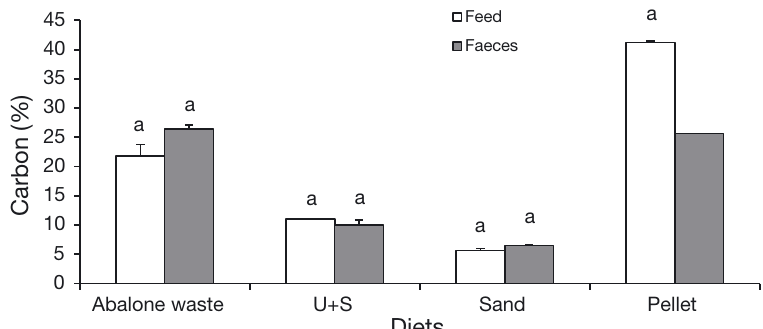
Fig. 4. Carbon content (%) of feed and faeces of Neostichopus grammatus fed 4 experimental diets. Data are mean ± SE (n = 4). Different letters above each bar within a column indicate a significant difference between feed and faeces (t -test, p < 0.05). U+S: Ulva lacinulata mixed with sand